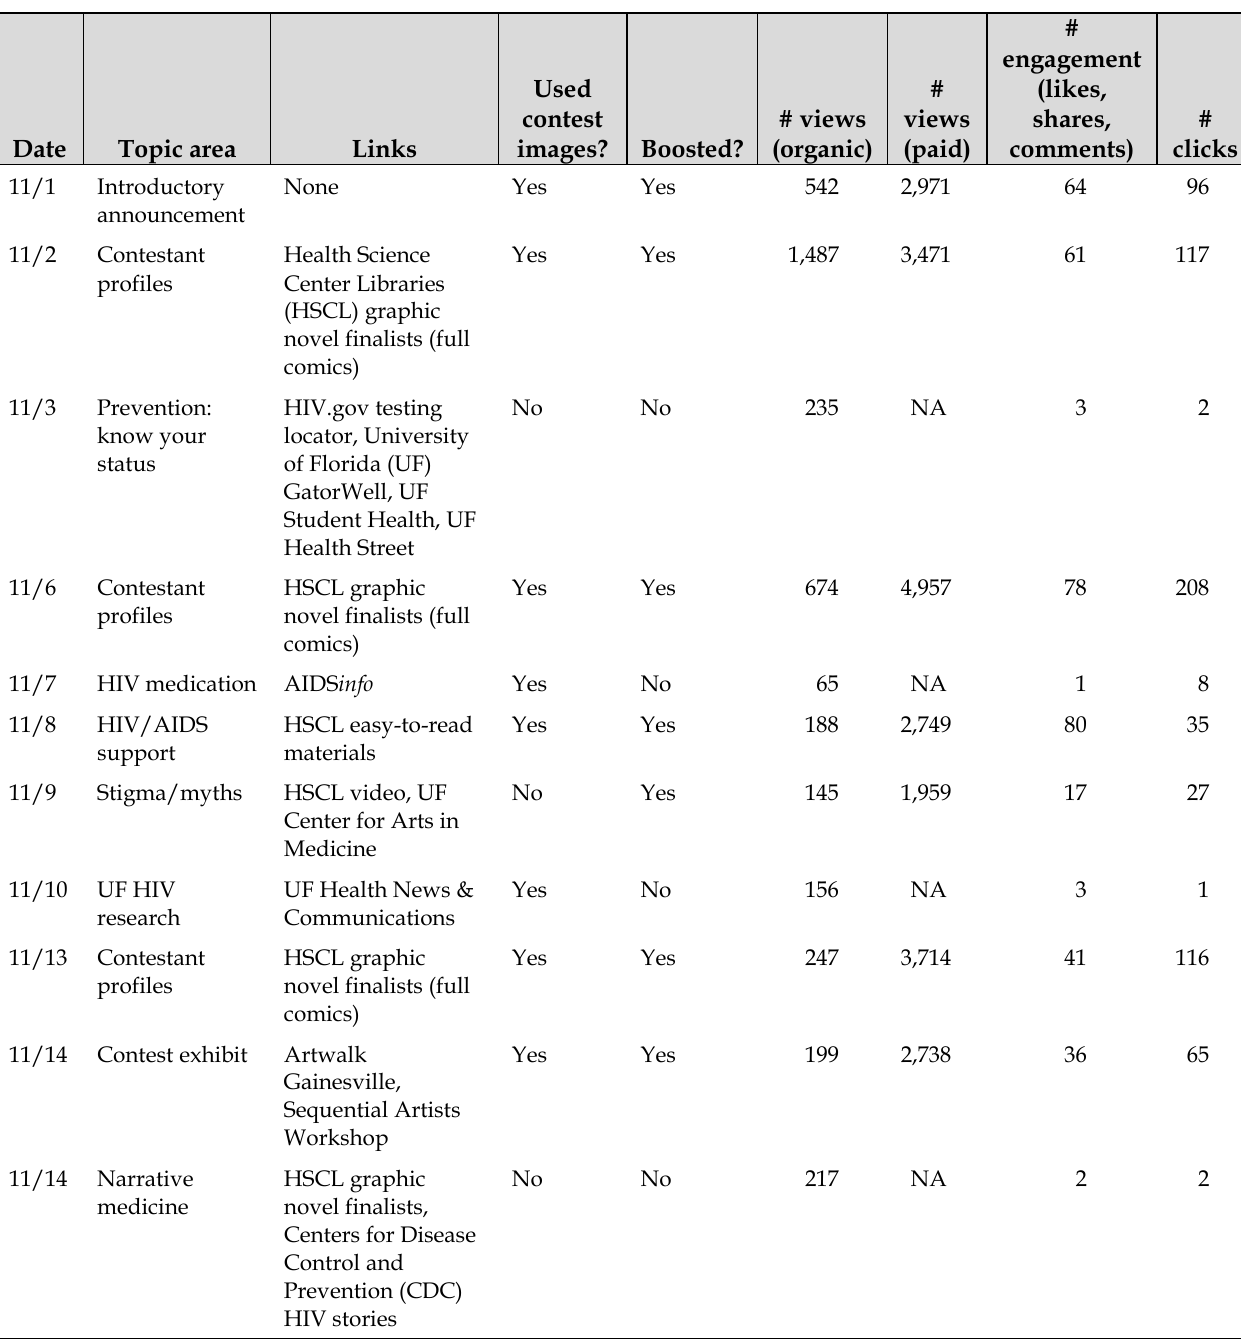
Table 1 Social media campaign posts, content, views, and